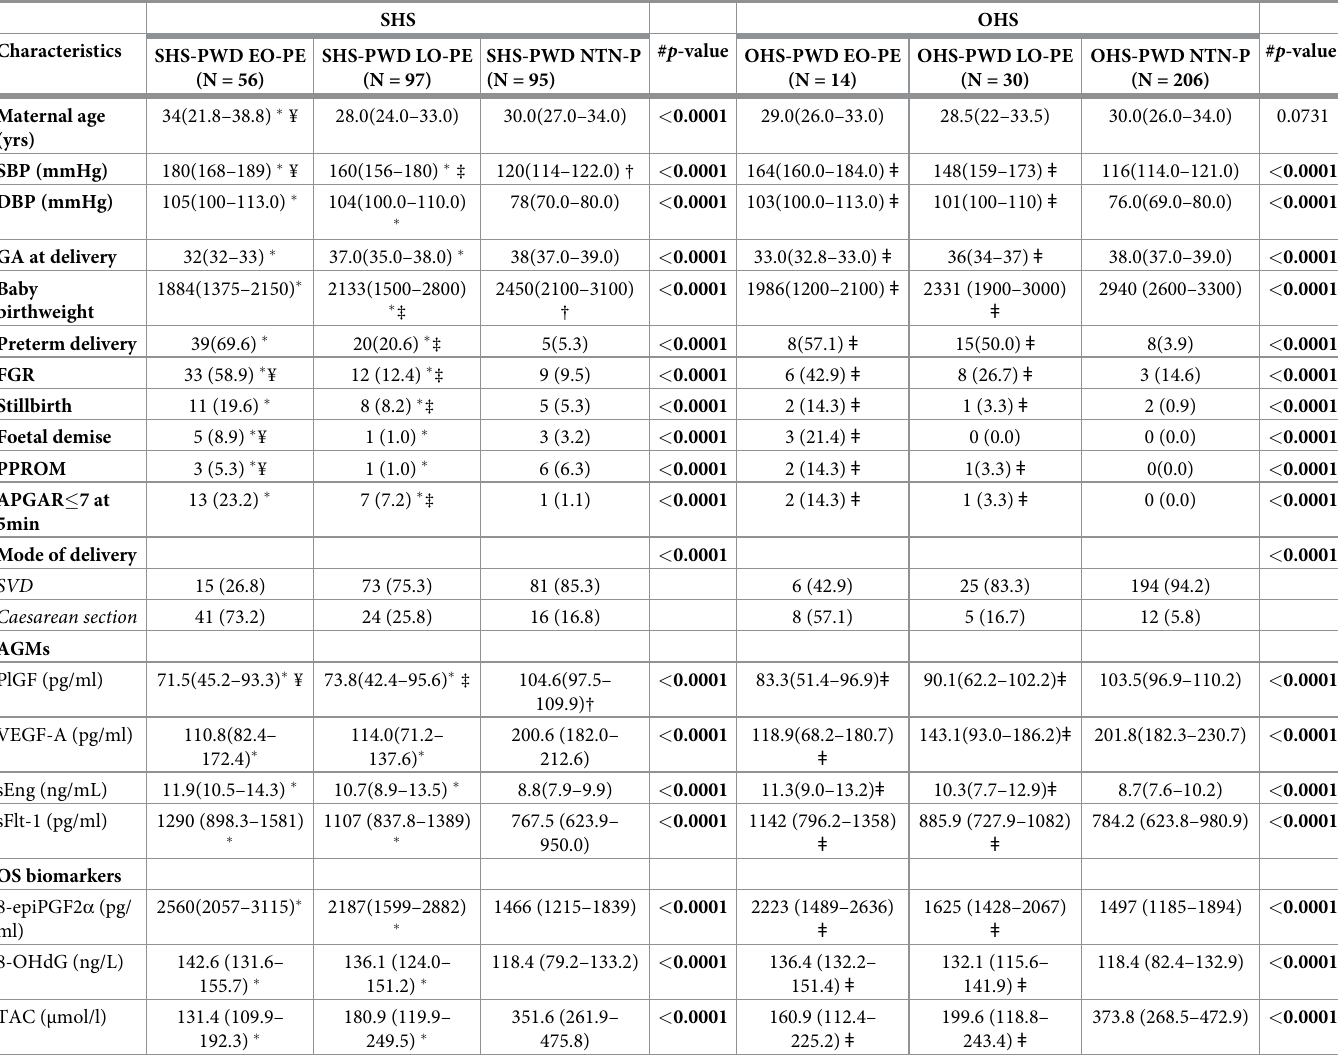
Table 2. Demographic data, clinical and adverse pregnancy outcomes of SHS and OHS-PWD EO-PE and LO-PE compared to NTN-P. SHS OHS